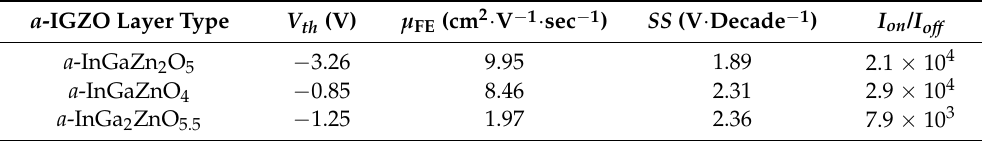
Figure 13. Transfer characteristics of TFT devices containing ( a ) a -InGaZn 2 O 5 , ( b ) a -InGaZnO 4 , and ( c ) a -InGa 2 ZnO 5.5 active channel layers subjected to post-annealing at 300 °C for 1 h in an ambient atmosphere.